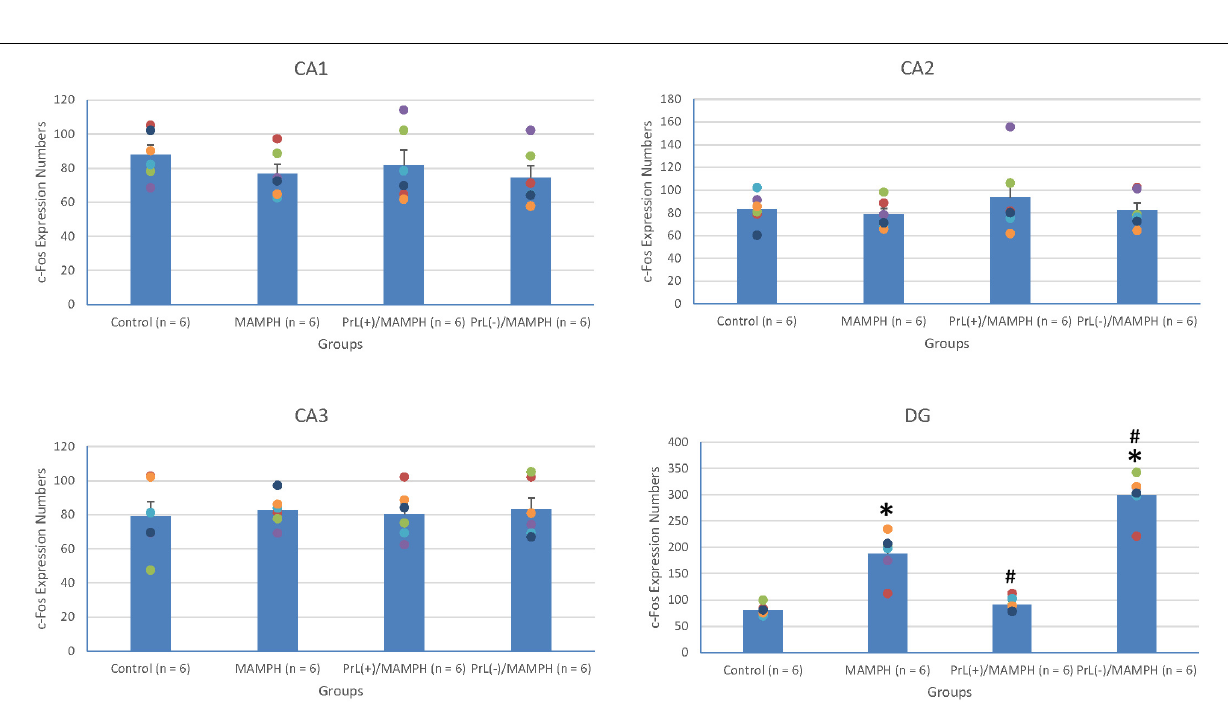
Frontiers in Aging Neuroscience |